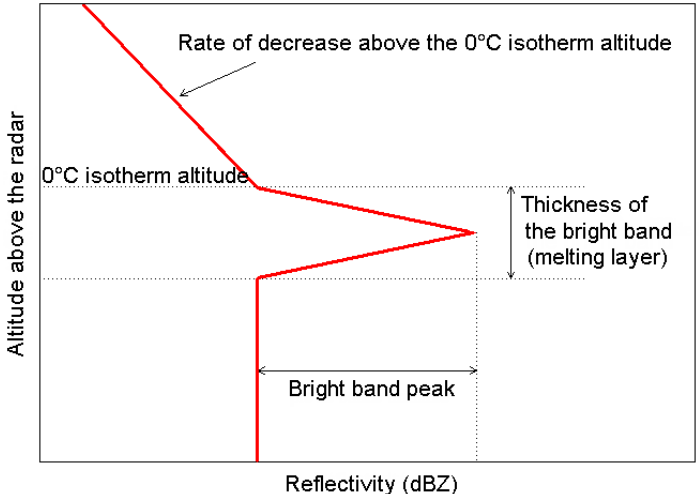
Figure 3. Example of vertical profile or reflectivity model defined above the radar altitude with four parameters.